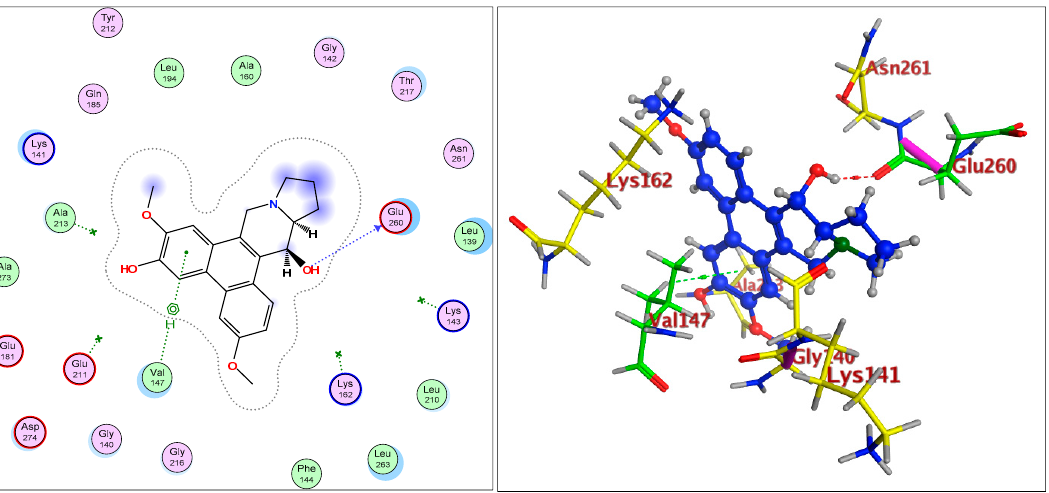
Figure 2. Overlay of compound ( 5 ) bound to the active site of ATP-binding pocket of Aurora-A.